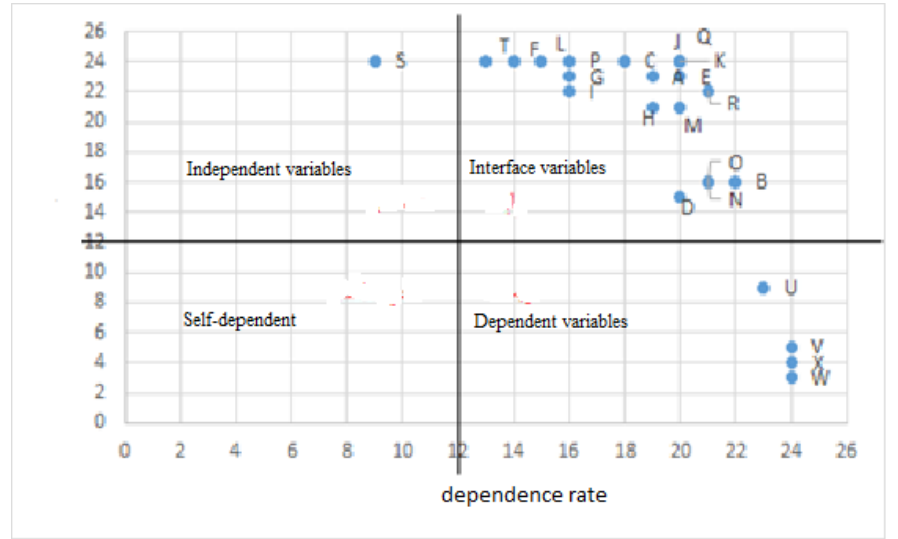
Figure 3: The influence of the influence-dependency power